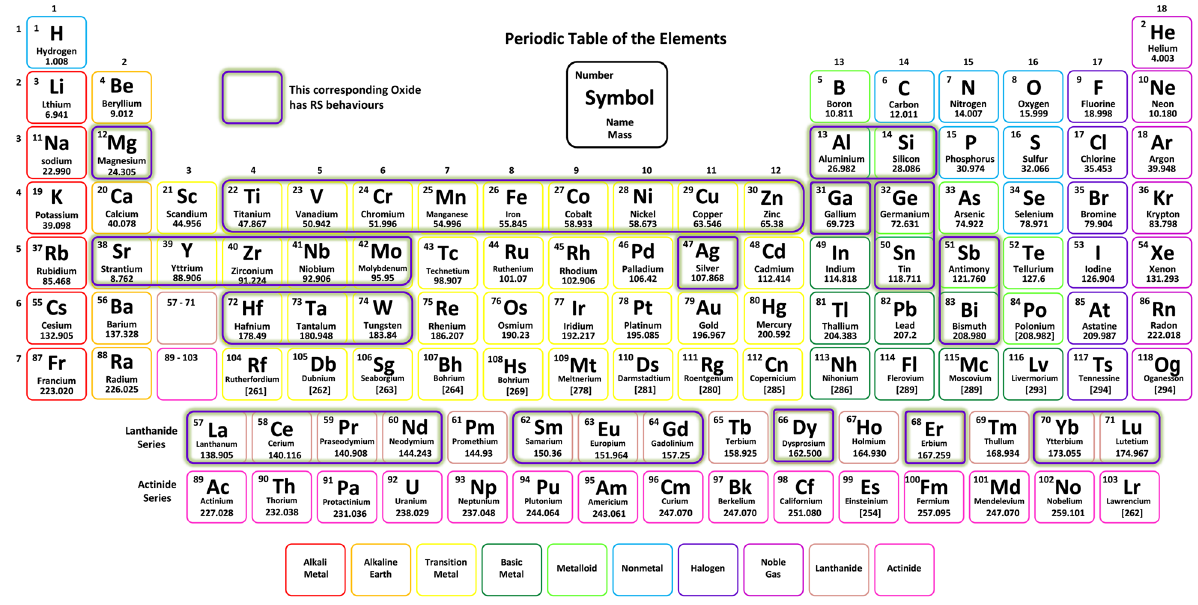
Fig. 16 Elements that show RS behaviour highlighted in the periodic table [142,